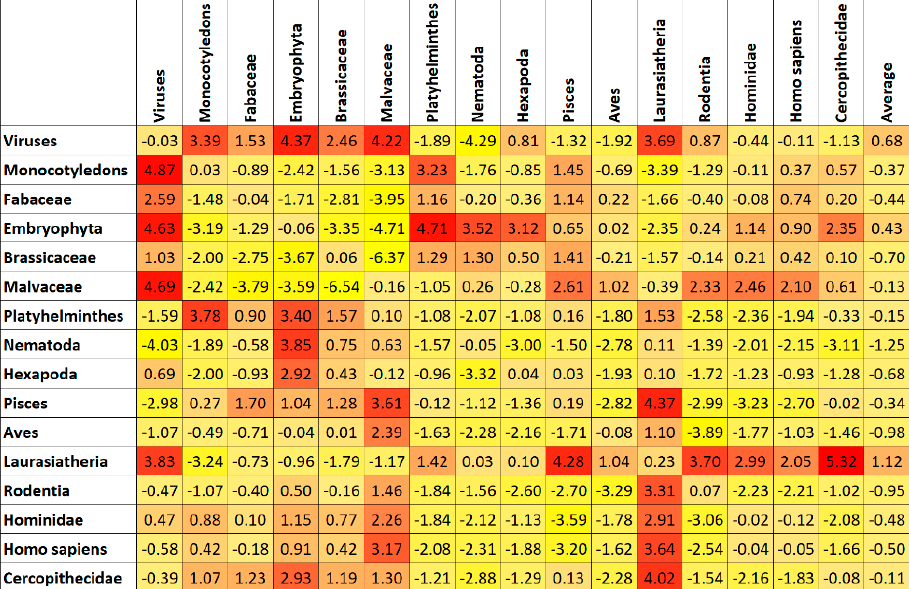
Figure 6. Difference between k-mer first–last distance and k-mers only. Yellow shades indicate better performance for k-mer first–last distance, while red shades indicate higher average classification accuracy for k-mers.